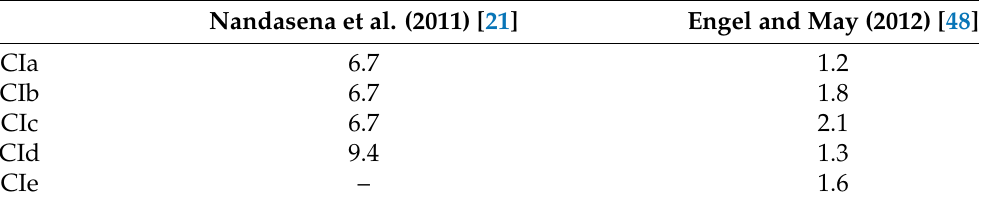
Table A24. Minimum wave heights H m (m) required to displace the boulders of the Ciardo coast.